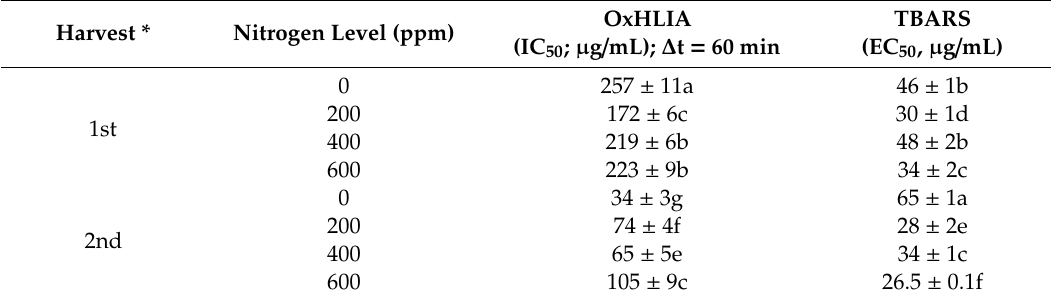
Table 9. Antioxidant activity of Centaurea raphanina subsp. mixta plants grown in 2 L pots under greenhouseconditions, inrelationtoharvestingtime(1stand2ndharvest)andnitrogenlevel(0–600ppm) (mean ± SD; n = 3). OxHLIA TBARS Harvest * Nitrogen Level (ppm) (IC 50 ; µ g / mL); ∆ t = 60 min (EC 50 , µ g / mL) 0 257 ± 11a 172 ± 1st